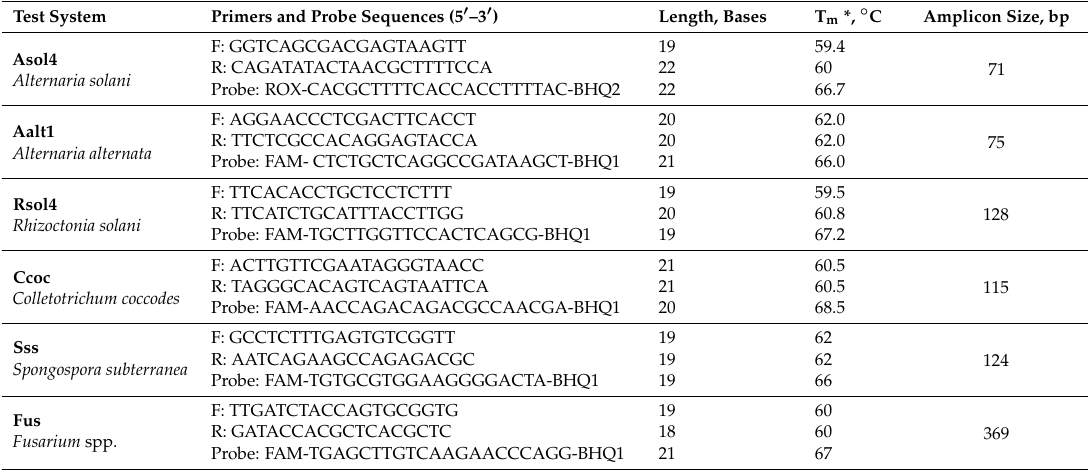
Table 2. Species-specific primers and probes designed for the qPCR-based diagnostics of six fungal pathogens of